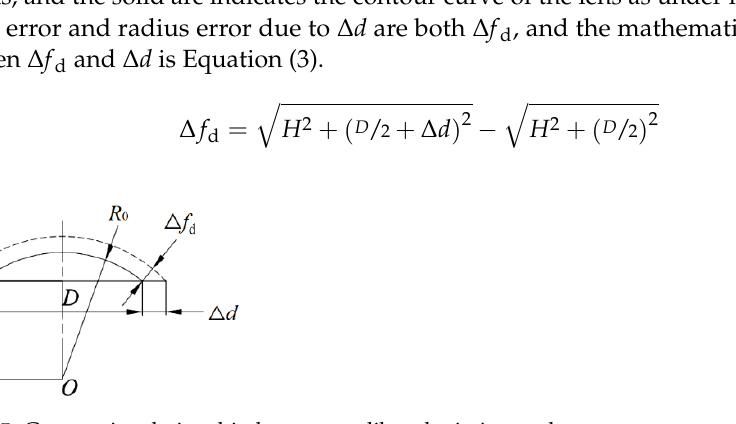
Figure 5. Geometric relationship between caliber deviation and measurement error.